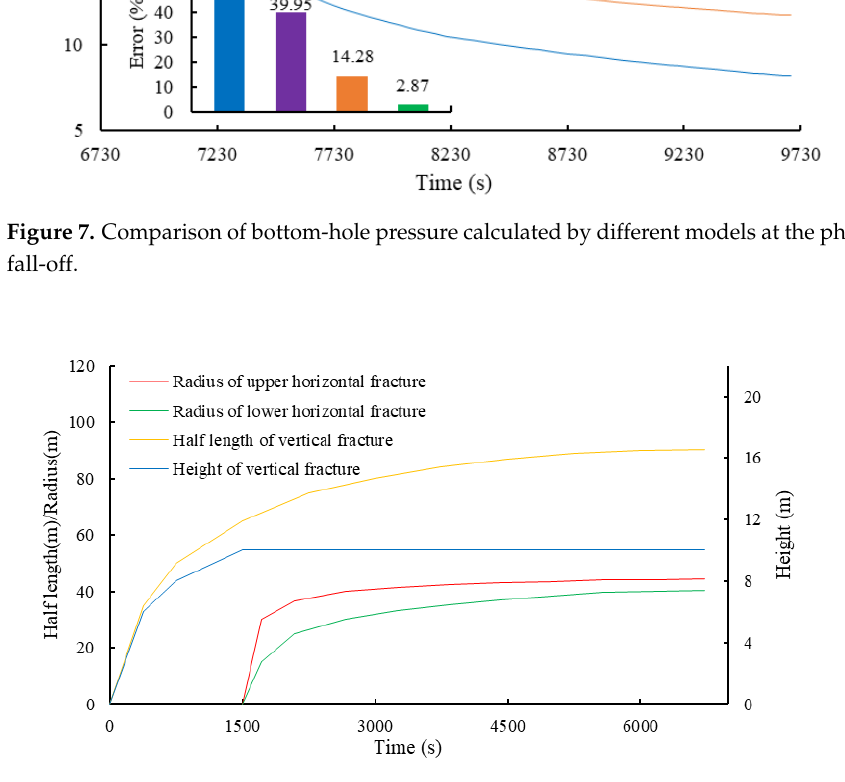
Figure 8. Variation diagram of fracture parameters during fracturing